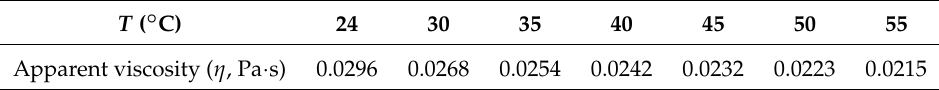
Table 3. Apparent viscosity at 100 s − 1 of fruit